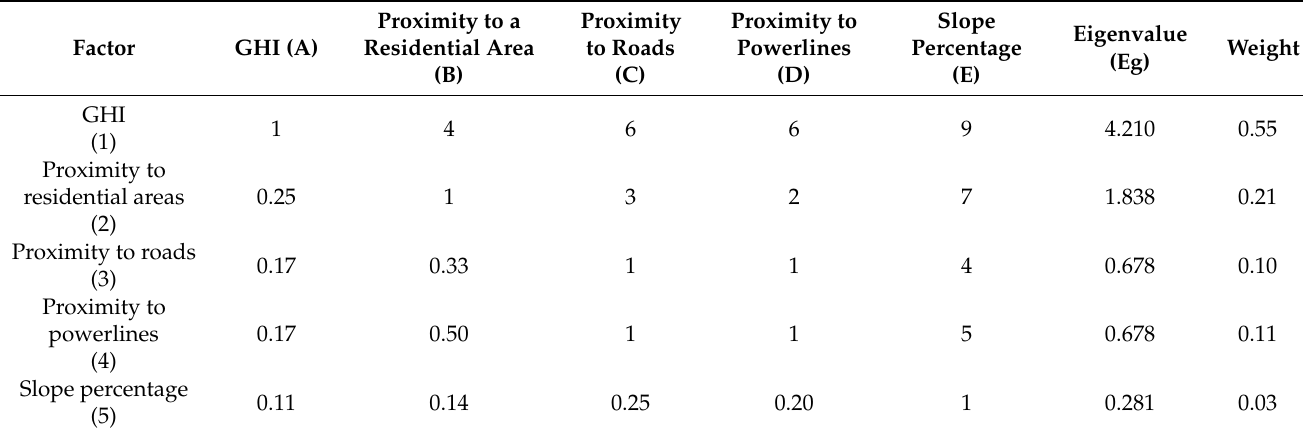
Table 5. AHP matrix for determining the weight of each factor [45].